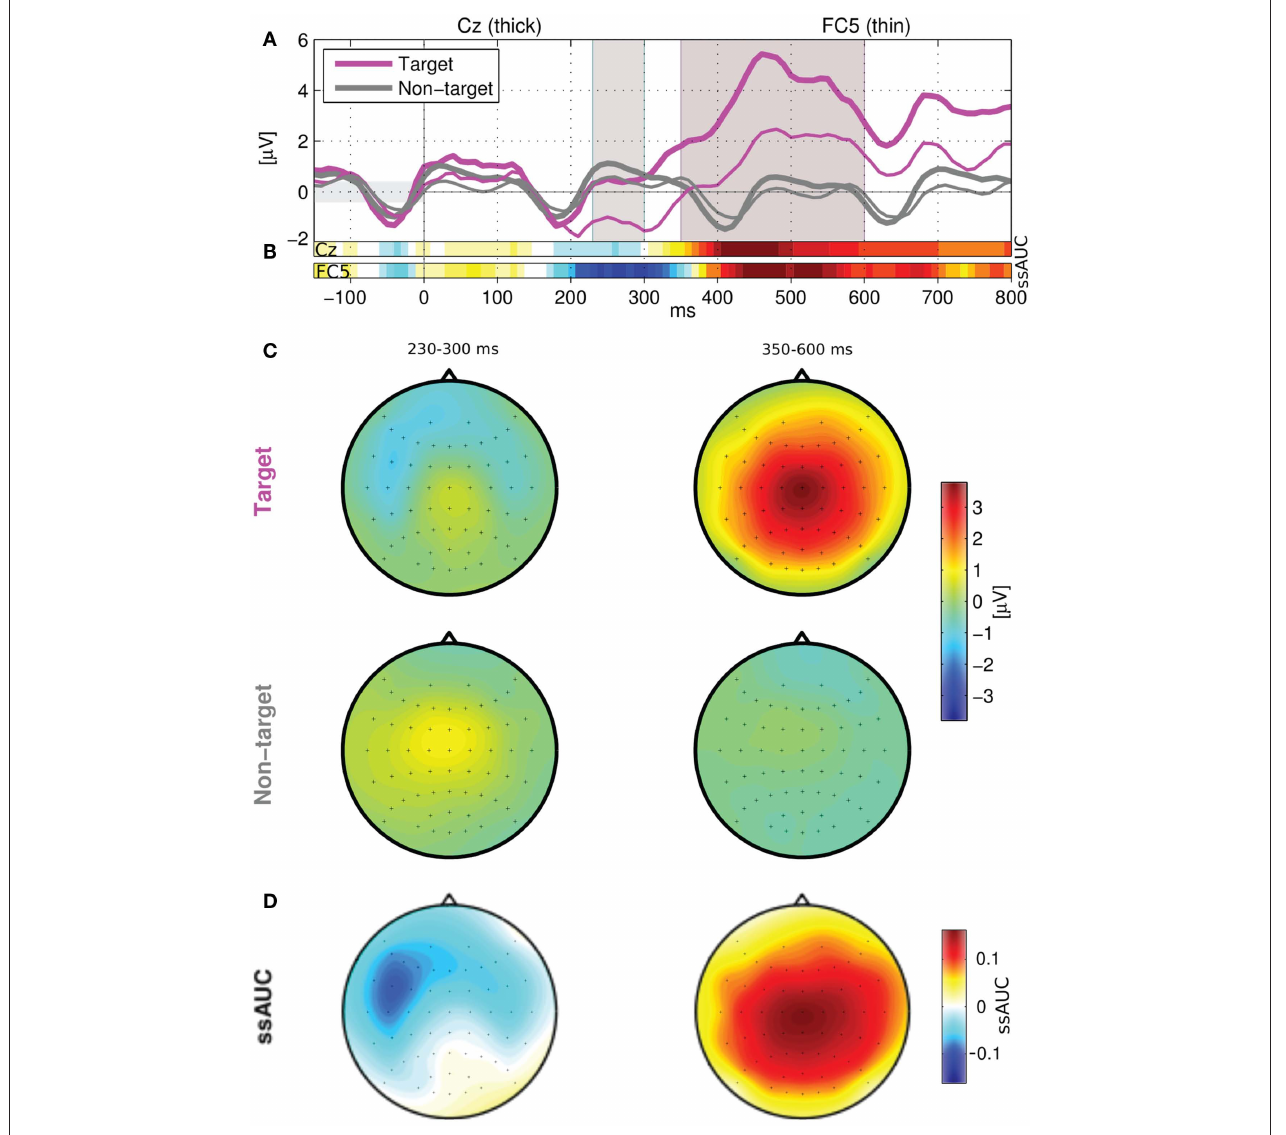
FIguRE 4 | (A) Grand averaged ERPs at electrodes Cz (thick lines) and FC5 (thin lines). The ssAUC bars (B) quantify the discriminative information for the two channels. The averaged ERP scalp maps of target and non-target stimuli for the two marked time frames are shown in (C) and the class discriminability (ssAUC values) is depicted in (D) . The scales for (B) and (D) are